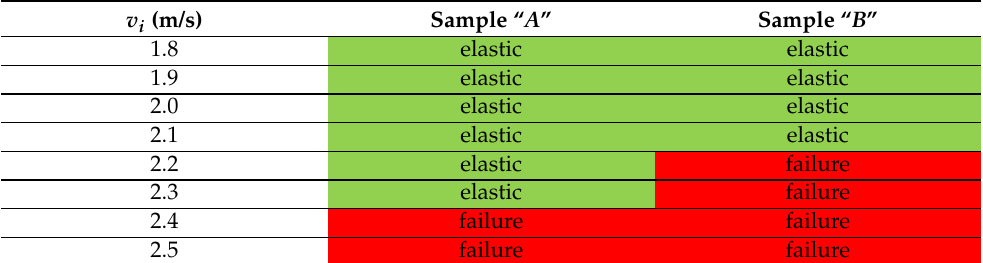
Table 9. Identification of the minimum kinetic energy of impact for